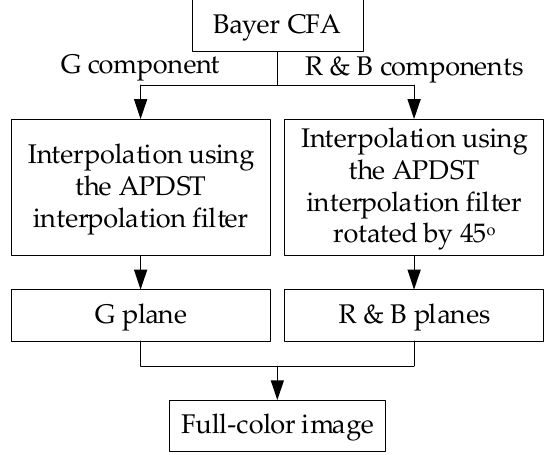
Figure 6. The block diagram of the proposed image demosaicking method.